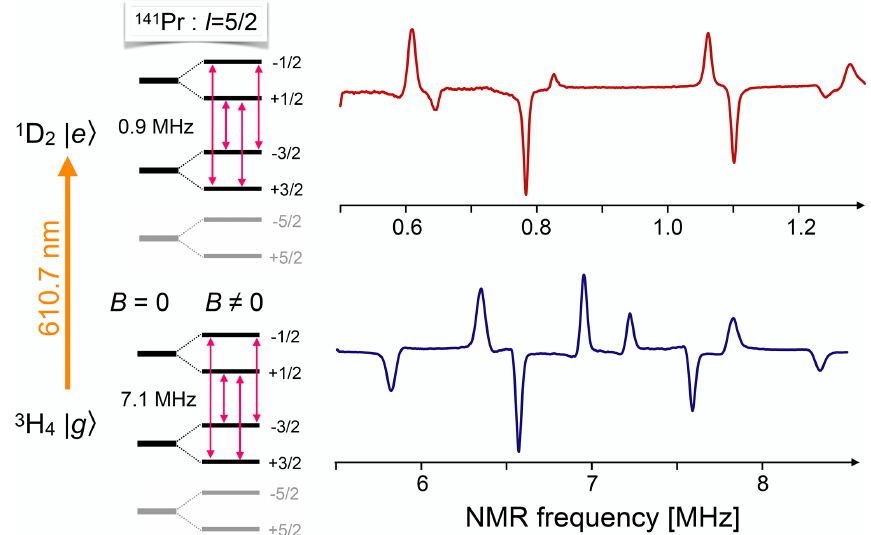
Figure 15. Energy levels and NMR spectra of 141 Pr in the ground and electronically excited states of Pr 3 + in a YAlO 3 host crystal, measured by coherent Raman scattering. The grey parts of the level scheme do not contribute to the spectra shown in the figure, but are included for completeness. The four positive lines correspond to the transitions of one crystallographic site, as marked in the level scheme. The four negative lines belong to the corresponding transitions in a different crystallographic site.